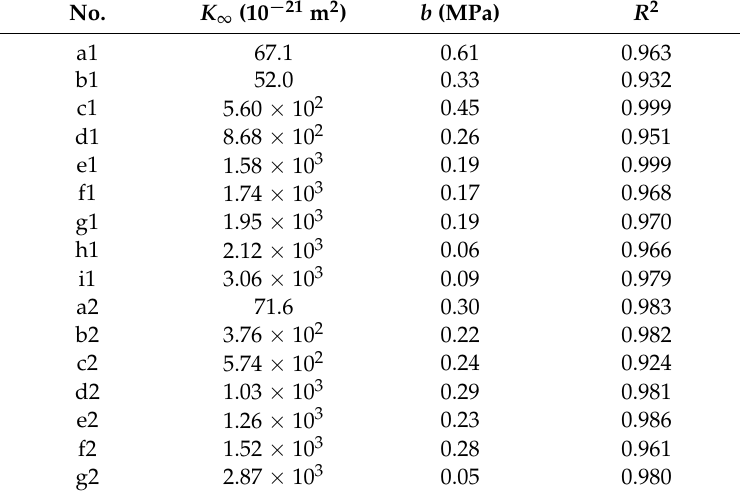
Table 6. The fitting